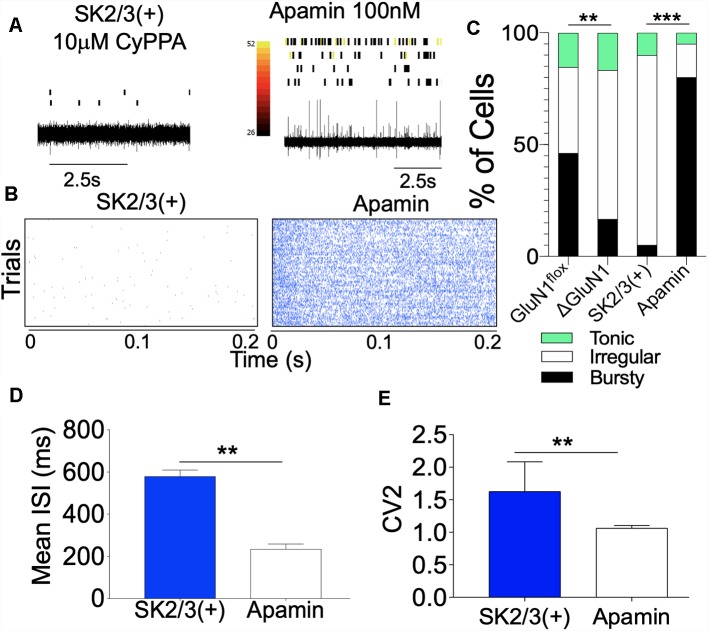
SK channel potentiation attenuates spontaneous CA1 firing. (A) Spike train with aligned rasters demonstrating CA1 dendritic field neural activity. (B) Perievent rasters demonstrating a change in neural activity following SK channel potentiation and inhibition. (C) Composite bar graph demonstrating percentage distribution of neuron units characterized by ISI properties. (D) Bar graph demonstrating Mean ISI (ms) duration. (E) Bar graph demonstrating regularity of firing (CV2 of ISI). (C–E; **p < 0.01, ***p < 0.001).